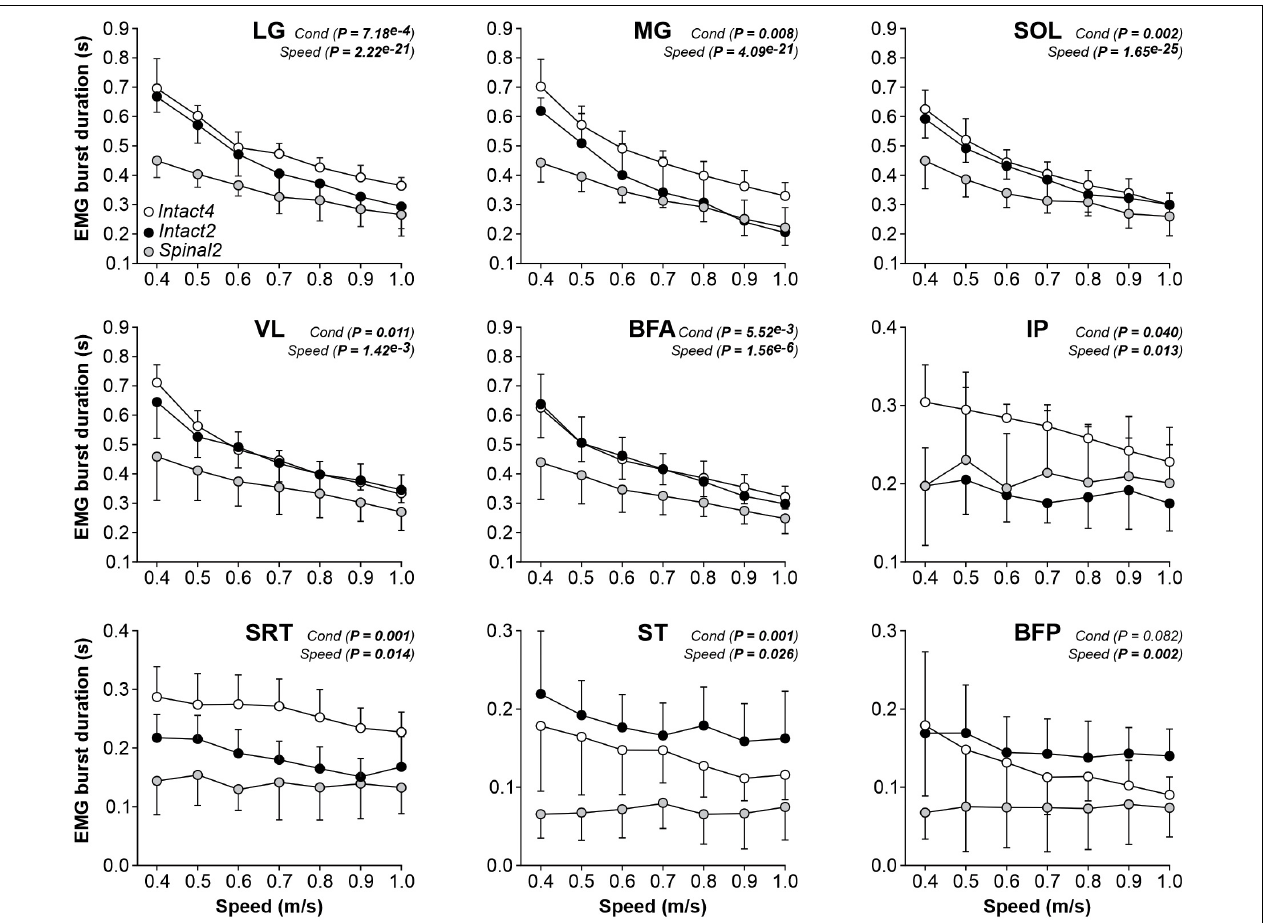
FIGURE 5 | Modulation of EMG burst durations during quadrupedal or hindlimb-only locomotion in intact and spinal cats across speed. The figure shows burst durations in nine hindlimb muscles during Intact4, Intact2 and Spinal2 conditions at seven treadmill speeds. At each speed, 6–15 cycles were averaged per cat. Each data point indicates the mean ± SD for the group. P values comparing conditions (Cond) and speeds are indicated (main effects of repeated-measures ANOVA). LG, lateral gastrocnemius ( n = 7 cats); MG, medial gastrocnemius ( n = 7 cats); SOL, soleus ( n = 8 cats); VL, vastus lateralis ( n = 6 cats); BFA, biceps femoris anterior ( n = 7 cats); IP, iliopsoas ( n = 6 cats); SRT, anterior sartorius ( n = 6 cats); ST, semitendinosus ( n = 7 cats); BFP, biceps femoris posterior ( n = 6